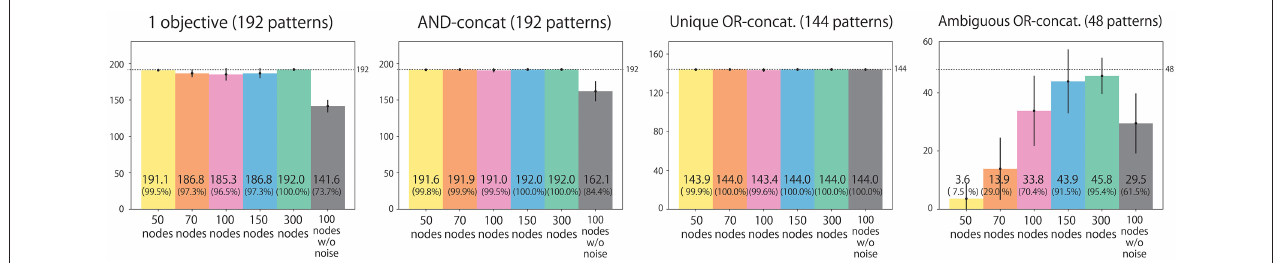
FIGURE 4 | Experiment 1 (flag task). Action generation performance. We evaluated performance by counting how many situation patterns each model learned appropriately with respect to each of the four situation types: (1) the instruction includes one objective; (2) the instruction is AND-concatenated; (3) the instruction is OR-concatenated, but there is only one correct action; and (4) the instruction is OR-concatenated, and two correct actions exist. Note that the written values are averages of 10 trials in which learning began with different seeds. Error bars represent standard deviations.